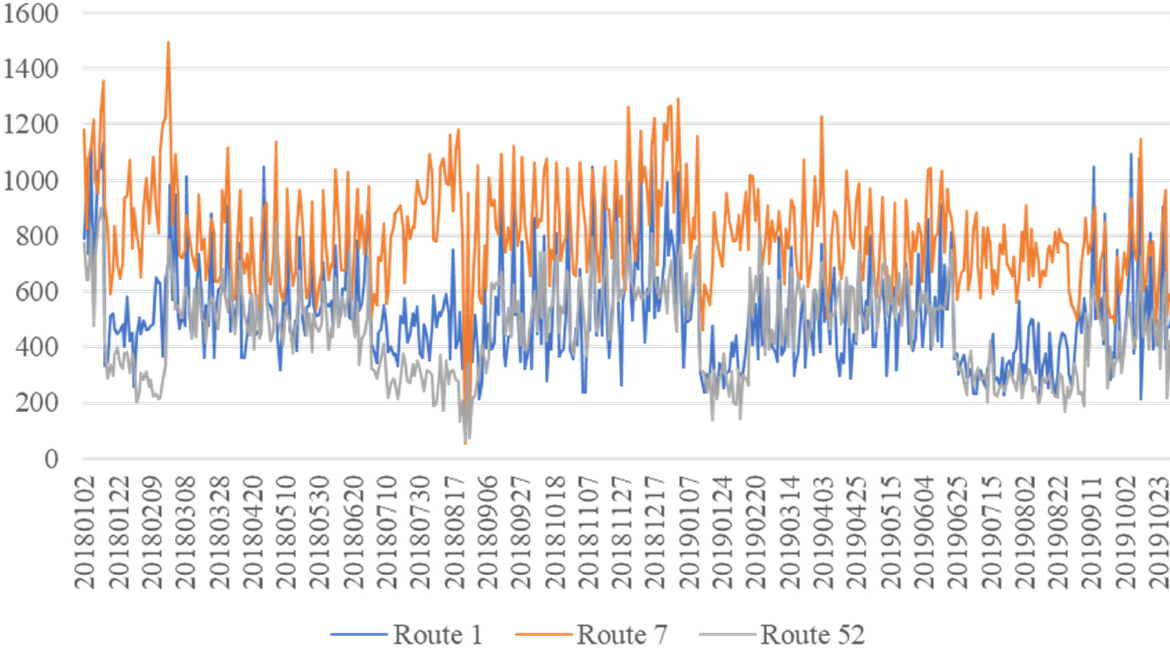
Figure 4. The number of passengers per day for the top three routes on weekdays.